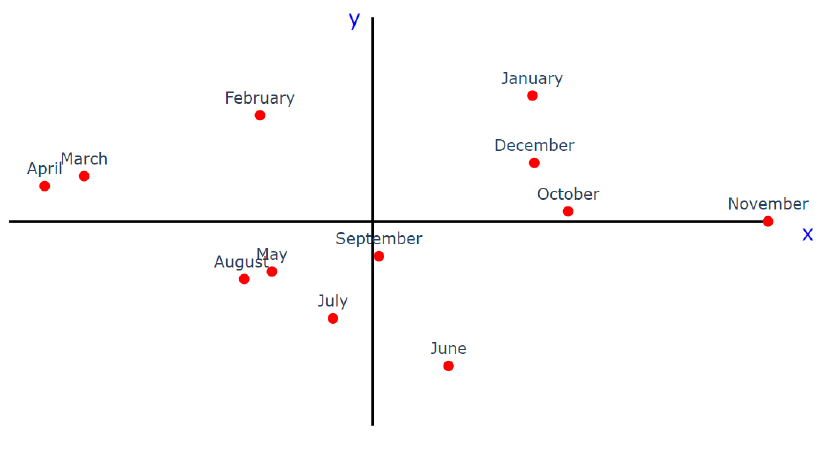
Figure 16. Month in the embedding